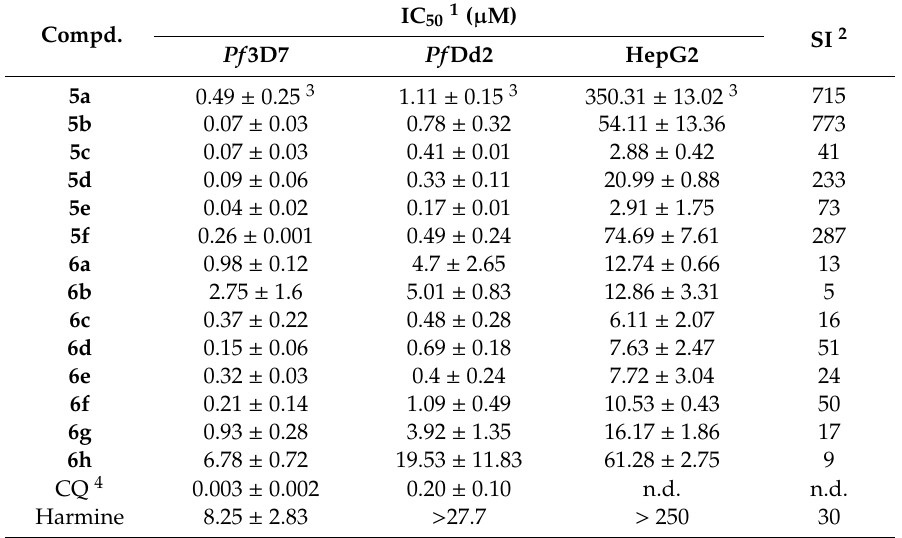
Table 1. In vitro screening of antiplasmodial activity of amide-type harmicines 5 and 6 against erythrocytic stage of P. falciparum ( Pf 3D7 and Pf Dd2 strains), cytotoxicity of human liver hepatocellular carcinoma cell line (HepG2) and calculated selectivity indices. Data for harmine and chloroquine are taken from